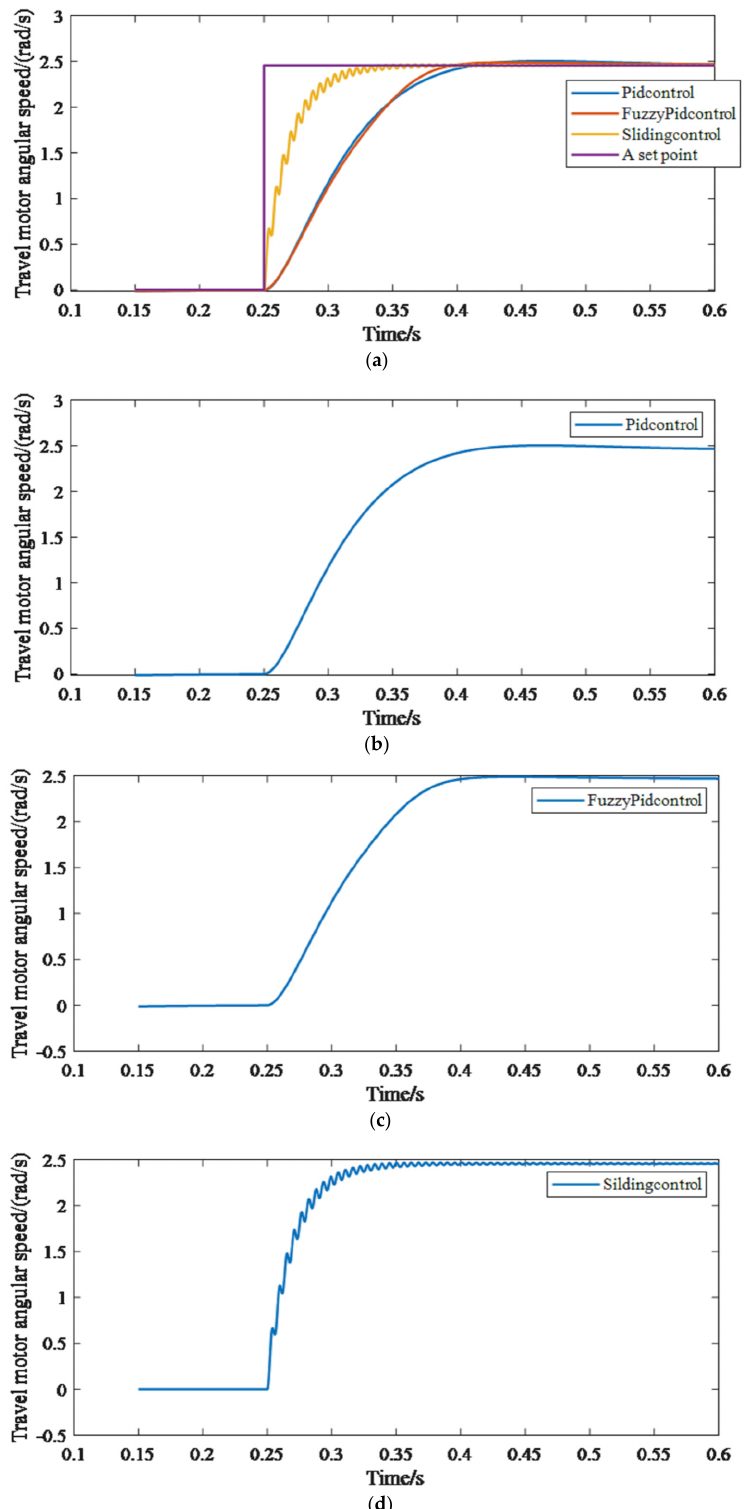
Figure 13. ( a ) Simulation results for constant load start of the travel drive system with three control strategies. ( b ) Simulation result for constant load start of the travel drive system with PID control strategy. ( c ) Simulation result for constant load start of the travel drive system with adaptive fuzzy PID control strategy. ( d ) Simulation result for constant load start of the travel drive system with sliding mode control strategy.